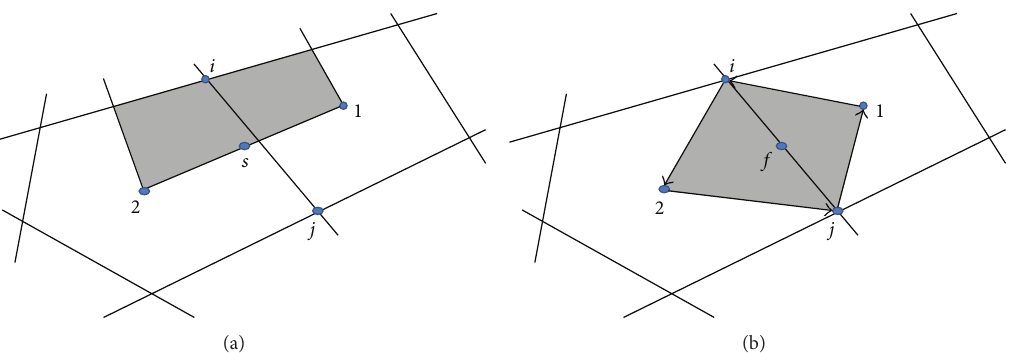
Figure 1: (a) Shaded part of the control volume used in the node-centered solver. (b) Control-volume used for face-centered gradient